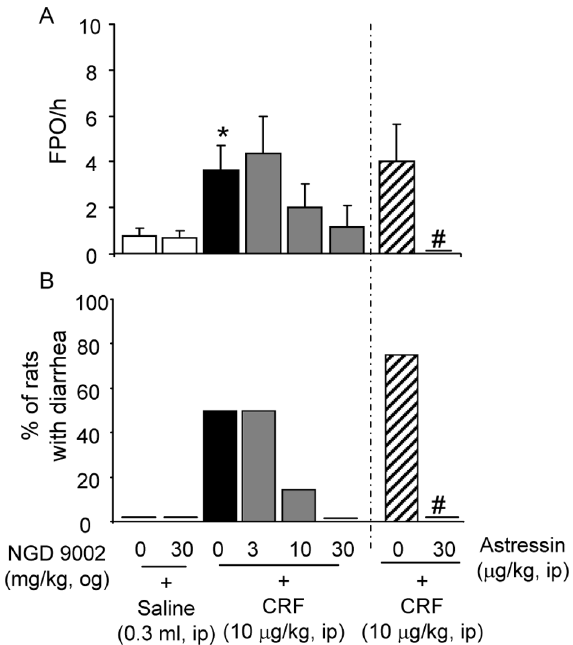
Figure 4. Oro-gastric (og) administration of NGD 9002 exerted a non-significant trend towards reduction of ip CRF-induced FPO and diarrhea in rats. Vehicle or NGD 9002 (3, 10 and 30 mg/kg) was given og 60 min before ip CRF-induced FPO (A) and diarrhea (B) which were monitored for the 60 min post ip injection. As a positive control, group of rats were pretreated with ip astressin (30 m g/kg), a non selective CRF 1 and CRF 2 receptor antagonist, just prior to ip CRF. Each bar in A represents the mean and SEM of FPO while in B they represent the mean % of 8 rats/group. *p , 0.05 vs saline + vehicle or saline + NGD 9002 (30 mg/kg); # p , 0.05 compared with the correspond- ing ip astressin + ip CRF. ANOVA, Student-Newman-Keuls; t-test; Fisher Exact test.